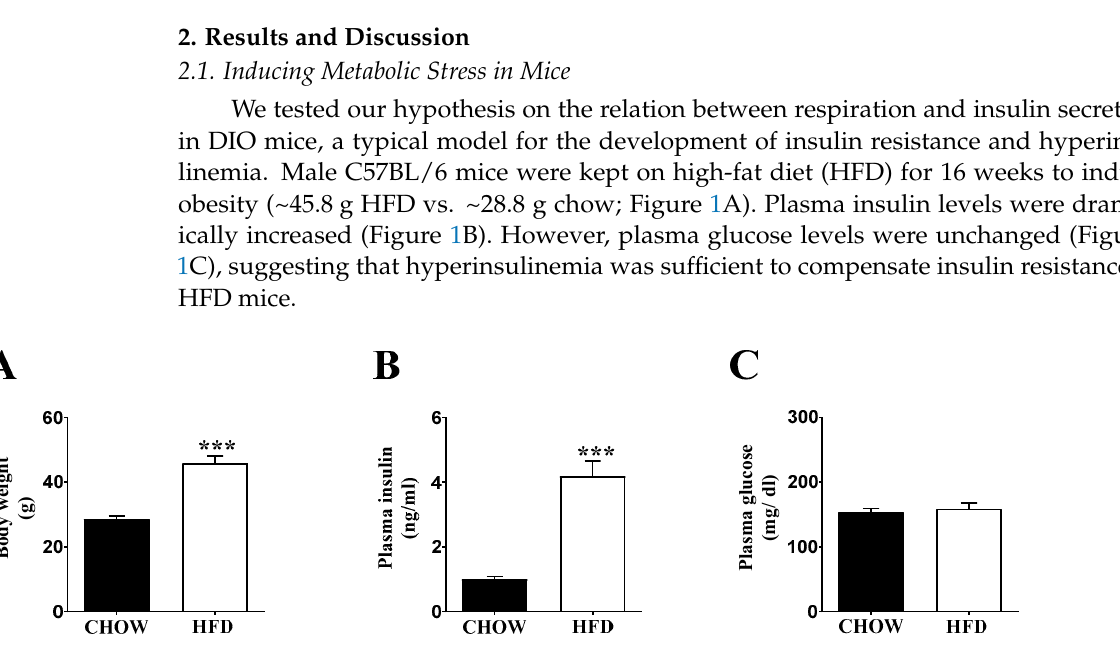
Figure 1. Characterization of chow (black bars) and HFD (white bars) fed C57BL/6 mice. ( A ) Body weight; ( B ) plasma insulin level; and ( C ) plasma glucose levels. The mice were 8 weeks old at the start of the feeding experiment. Data are represented as ± SEM ( n = 8 mice per group). Statistical significance of mean differences was tested by unpaired two-tailed student t -test. p < 0.001 (***).